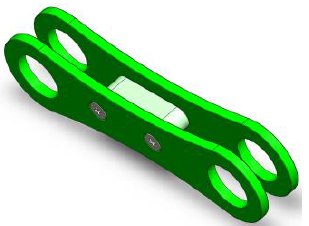
Figure 14. Realization of the connecting rod linkage in the prototype.